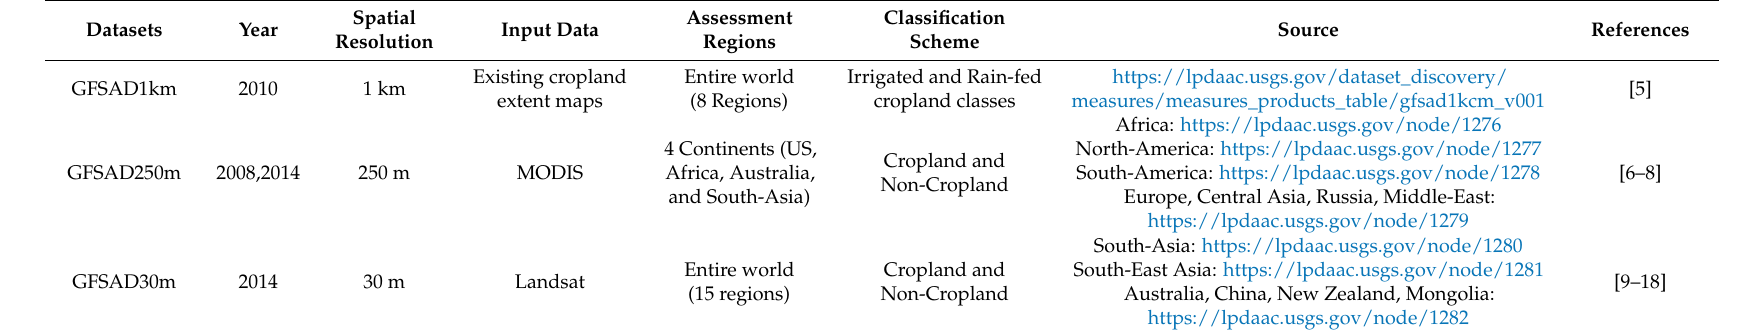
Table 2. Description of the three different GFSAD cropland extent